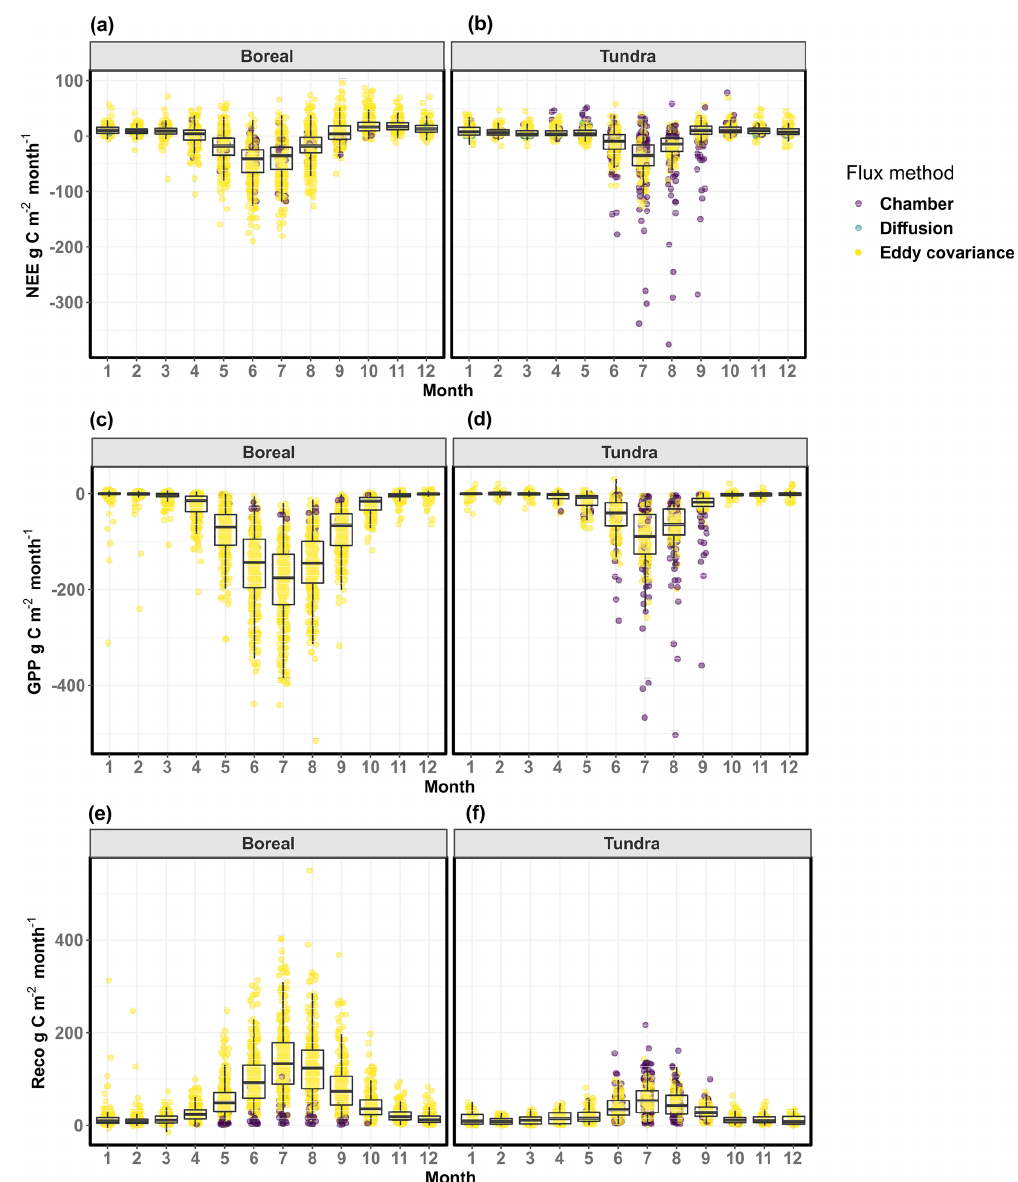
Figure 7. The distribution of net ecosystem exchange (NEE; a, b ), gross primary productivity (GPP; c, d ), and ecosystem respiration (Reco; e, f ) across the months and biomes, colored by the flux measurement technique. Positive numbers for NEE indicate net CO 2 loss to the atmosphere (i.e., CO 2 source), and negative numbers indicate net CO 2 uptake by the ecosystem (i.e., CO 2 sink). For consistency, GPP is presented as negative values and Reco as positive. The boxes correspond to the 25th and 75th percentiles. The lines denote the 1.5 IQR of the lower and higher quartile, where IQR is the inter-quartile range, or distance between the first and third quartiles. There is not much chamber data from the boreal regions as they capture NEE only at treeless